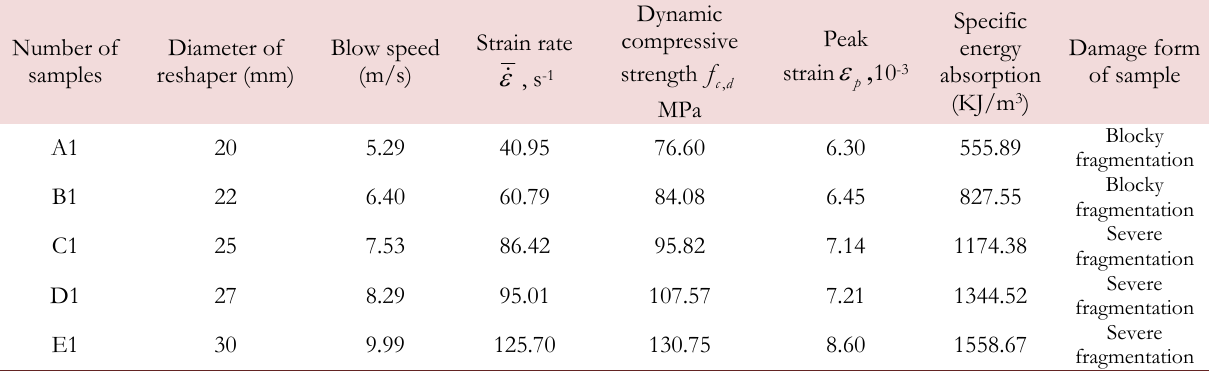
Table 3: SHPB test results of concrete.